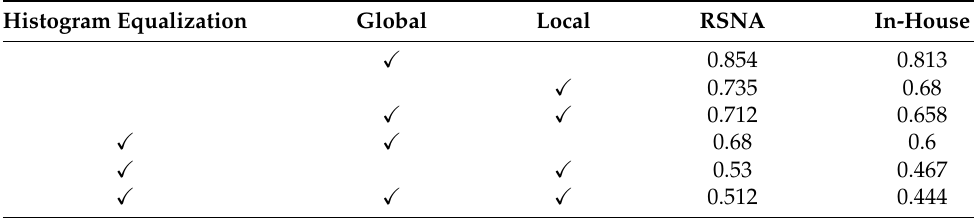
Table 4. The ablation study results in terms of histogram equalization, global and local.